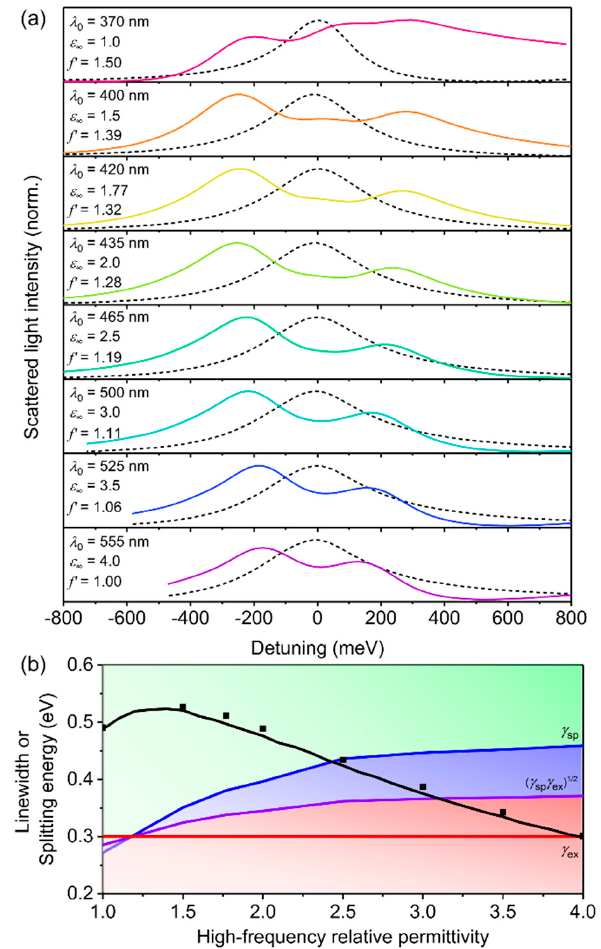
Figure 5. Variation of high-frequency relative permittivity, ε ∞ , for core-shell structures with a single Lorentzian oscillator shell with h = 40 nm, f = 0.10, and ħγ = 0.30 eV. ( a ) Normalized scattering spectra calculated using FDTD simulations. Note that λ 0 was selected as the LSPR wavelength of bare AgNPs in a background relative permittivity equal to ε ∞ (black dashed line). The f’ values listed are the scaling factors by which f was divided in order to have normalized amplitudes of the imaginary components of the relative permittivity to account for the shifted λ 0 . ( b ) Splitting energy for hybrid plasmon–exciton modes calculated using FDTD simulations (symbols) and Mie theory (black line). The background shading represents the coupling regimes (green—strong coupling; blue—intermediate coupling; red—weak coupling) as defined by the linewidths of the surface plasmon ( γ sp —blue line), the exciton ( γ ex —red line), and the relationship: sp ex (purple line), given in Equations (7)–(9).